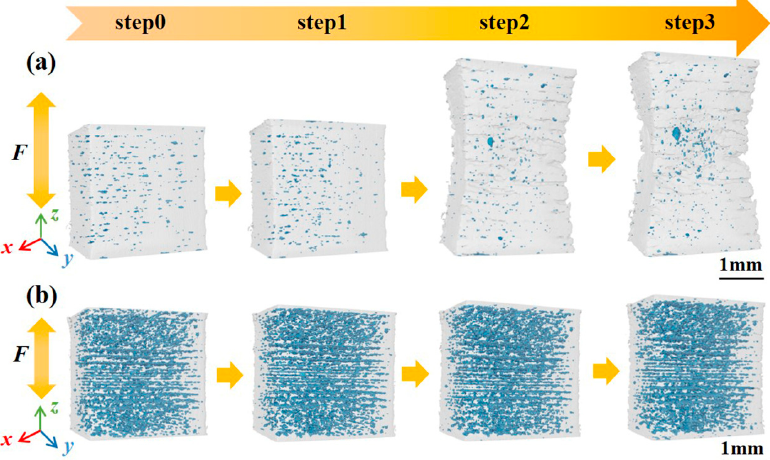
Figure 3. Volume renderings of VOI2 at different loading steps: ( a ) Specimen 400 and ( b ) Specimen 1000.